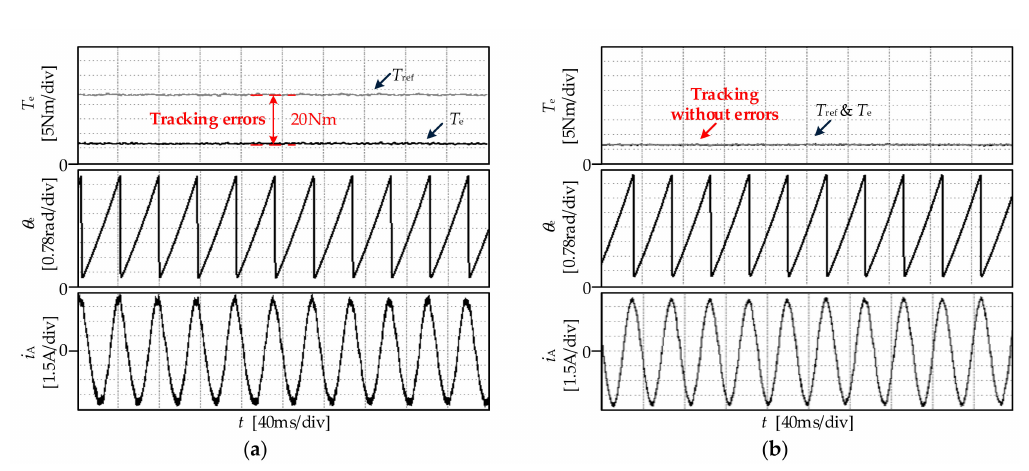
Figure 15. Experimental waveforms with / without compensation for the proposed DTC-SVM. ( a ) Without compensation; ( b ) with